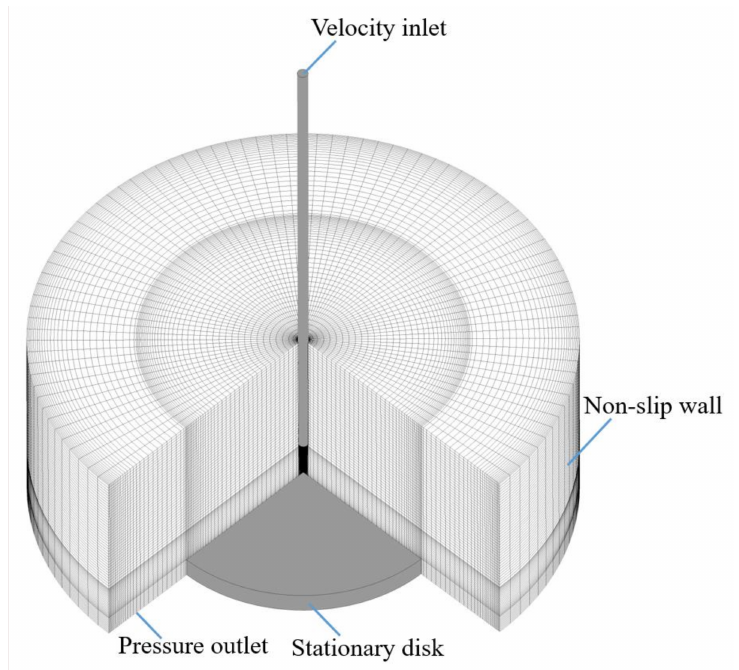
Figure 3. Grid of submerged impinging jet calculation